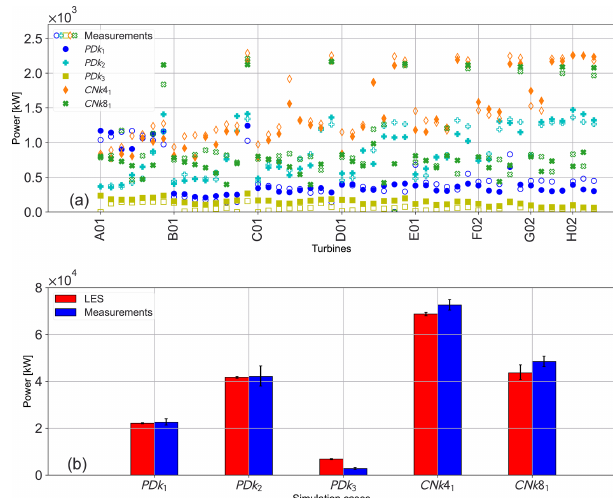
Figure 11. Comparison of LES time-averaged power output of in- dividual turbines (a) and total wind farm power output (b) against field SCADA measurements. Error bars represent 95 percent con- fidence intervals on the mean and are computed using the block– bootstrap method and time windows of 600s and 1000 bootstrap samples.